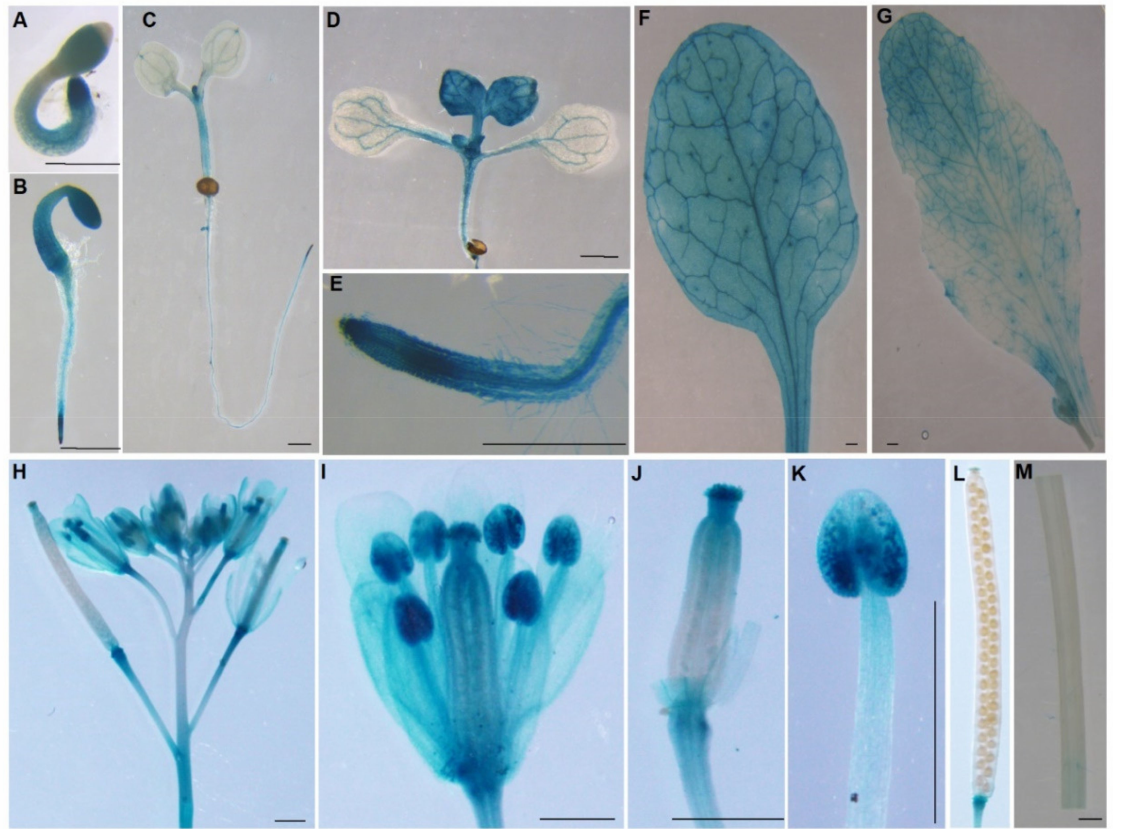
Figure 2. Spatial and temporal expression of AtPDI11. Spatiotemporal expression patterns of the AtPDI11 gene driven by its native promoter fused with GUS gene in transgenic plants. Promoter activity was visualized by histochemical GUS staining. ( A ) One-day-old seedlings. ( B ) Two-day-old seedlings. ( C ) Five-day-old seedlings. ( D ) Two-week-old seedling leaves. ( E ) Two-week-old seedling roots. ( F ) Rosette leaf of a four-week-old plant. ( G ) Cauline leaf of a four-week-old plant. ( H – L ) Inflorescence, flowers, stigma, anther, and siliques of five-week-old plant. ( M ) Stem of 5-week-old plant. Bar = 1